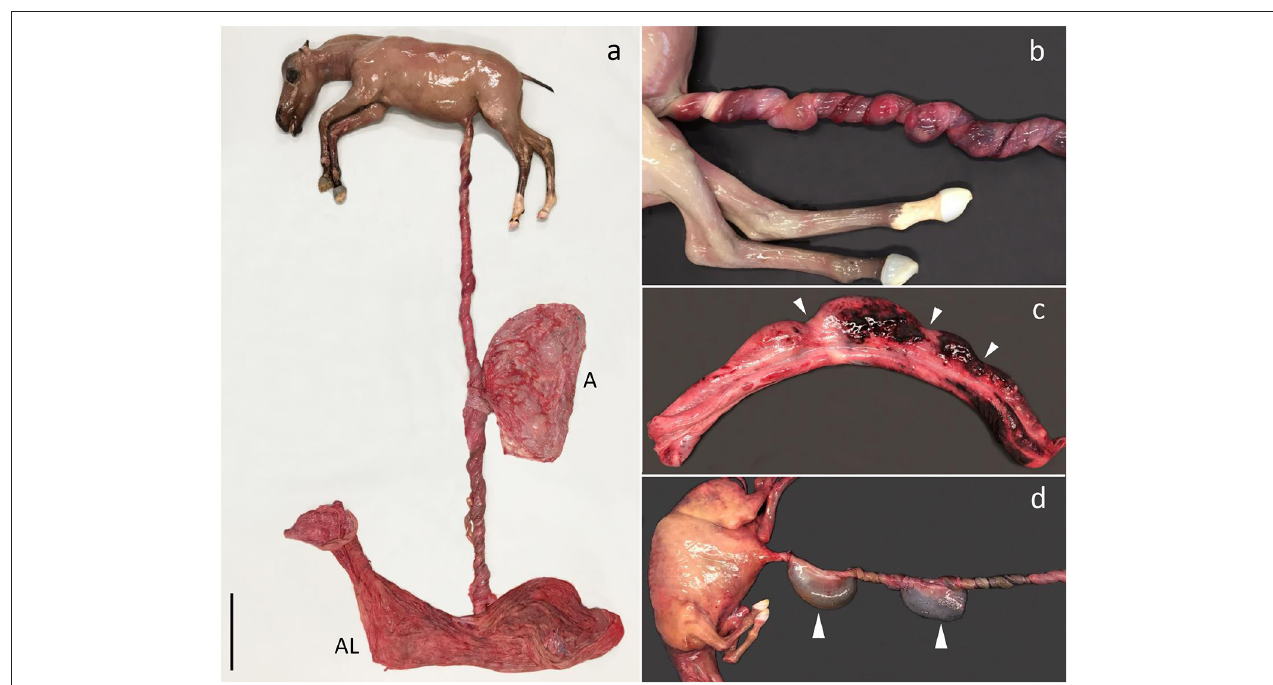
FIGURE 2 | Umbilical cord torsion. (a) Fetus aborted due to multiple torsions of the umbilical cord (UC) (13 × 360 ◦ ) involving both the intraamniotic and intra-allantoic portions. The UC had a total length of 175cm. Aborted at gestation day (AGD) 224, A, amnion; AL, allantochorion. (b) Multiple torsions of the intraamniotic portion of the UC, AGD 221. (c) UC segment after untwisting of torsions. Notice the pale torsion furrows (arrowheads) separating distended segments of the UC with hemorrhage, AGD 243; (d) Multiple torsions of the intraamniotic portion of the UC. The torsions have obstructed the urinary flow through the allantoic duct and saccular ectasia of the duct has developed as a result (arrowheads). The size of the abdomen is increased due to urinary stasis causing extensive distension of the urinary bladder. AGD 155. All shown fetuses are